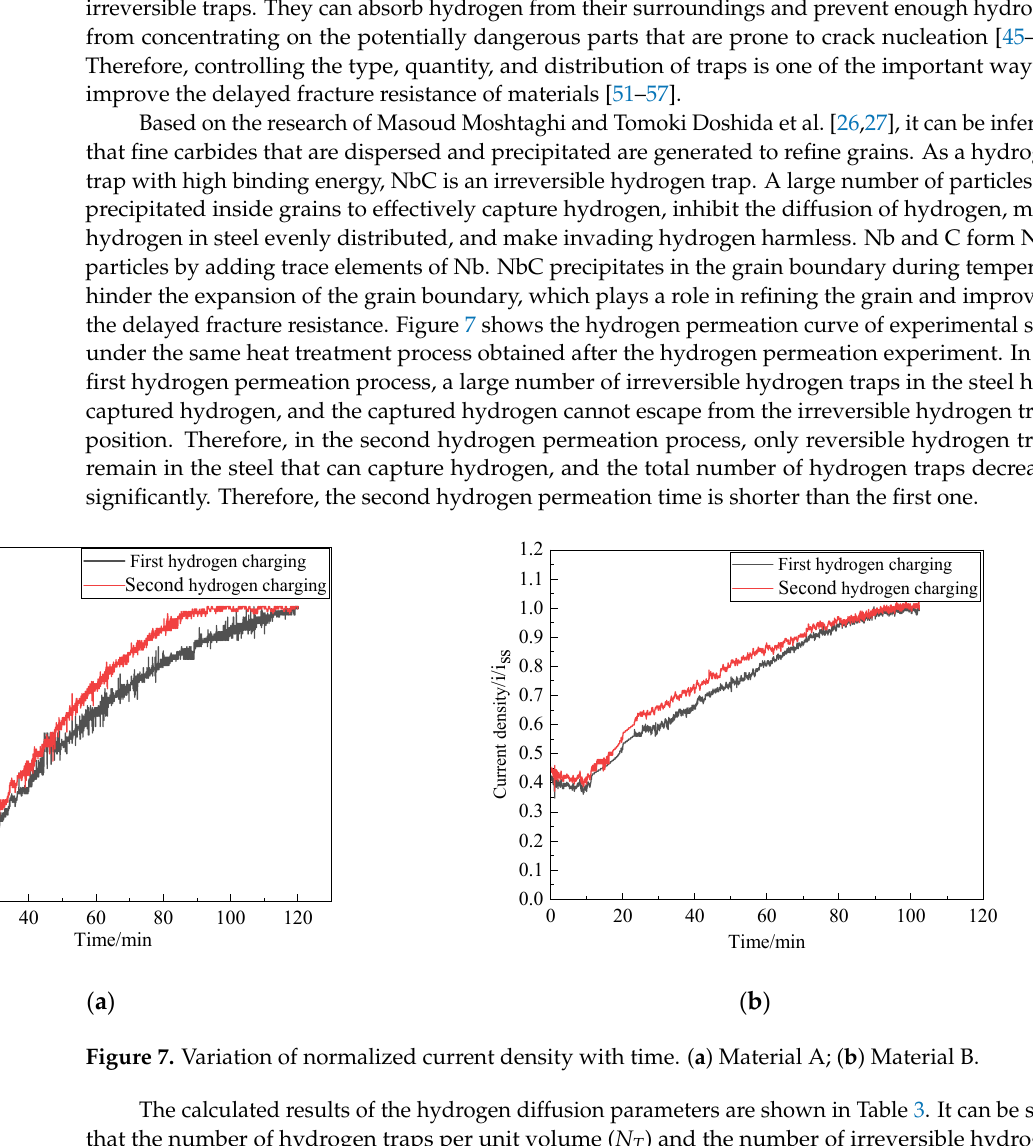
Table 3. Calculation results of hydrogen diffusion